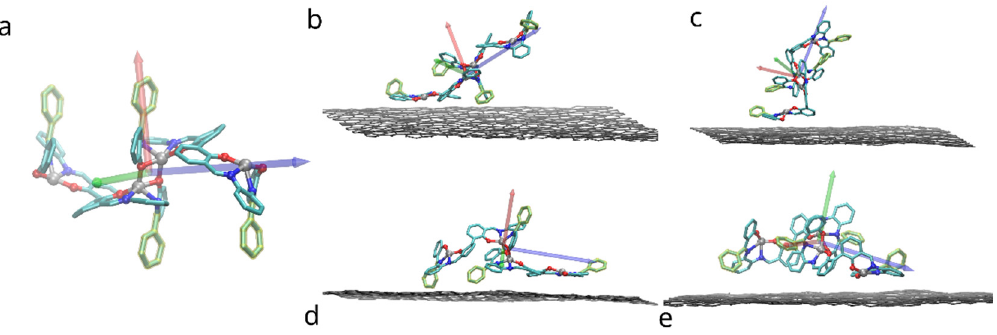
Figure 3. Placement of the bis-(Zn)salphen dimer with functional phenyl rings (highlighted with yellow) atop of graphene surface: ( a ) a compound dimer with axes indicating orientation, ( b – e ) variants of placement (after relaxation), axes indicate rotation of dimer. Only topmost graphene layer is shown for clarity, also solvent molecules and hydrogen atoms of compound are omitted.